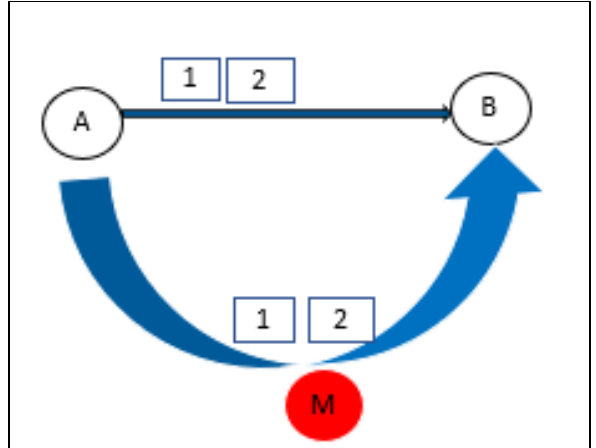
Figure 7. An illustration of the replay